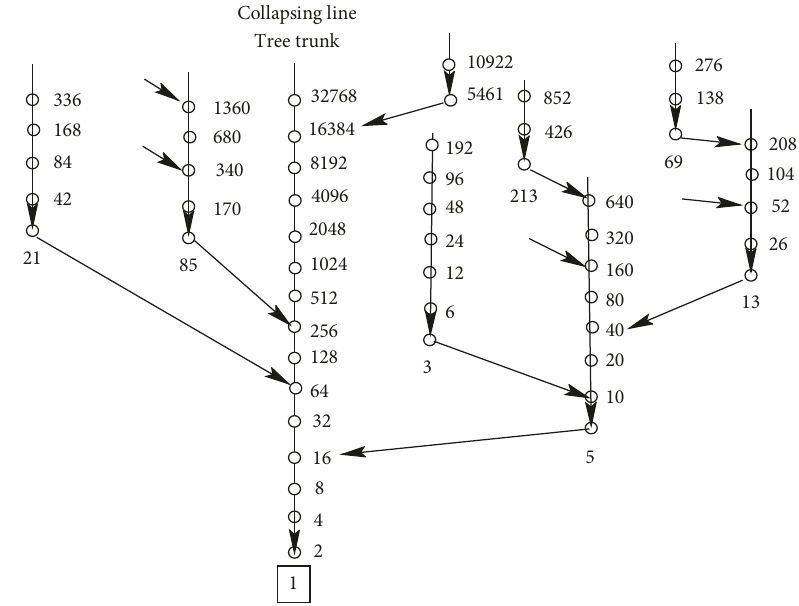
Figure 1: Representative of Collatz